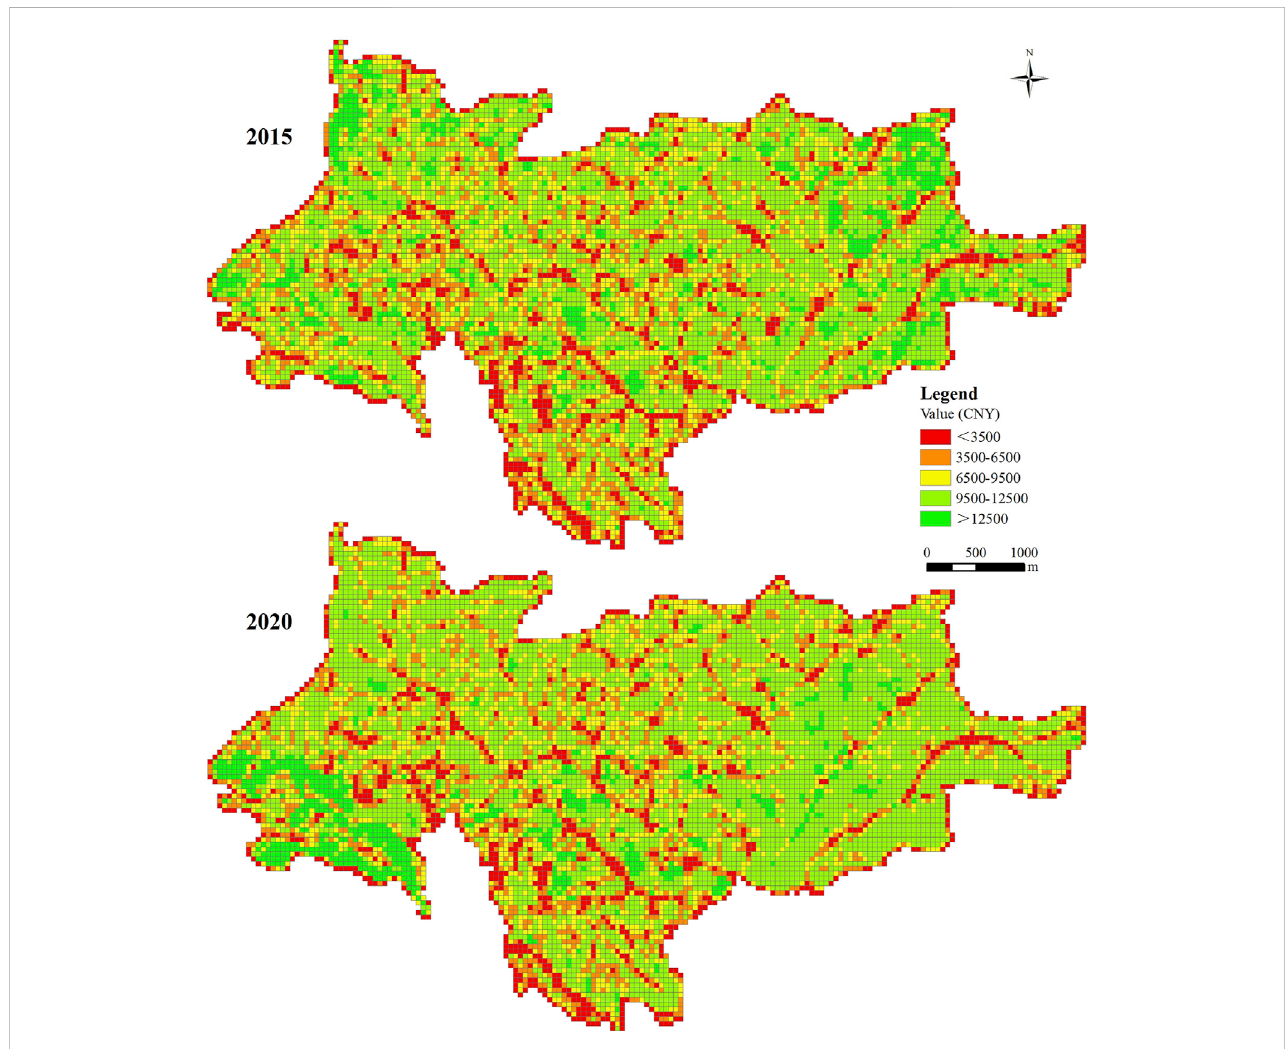
FIGURE 5 Spatial distribution of ecosystem service